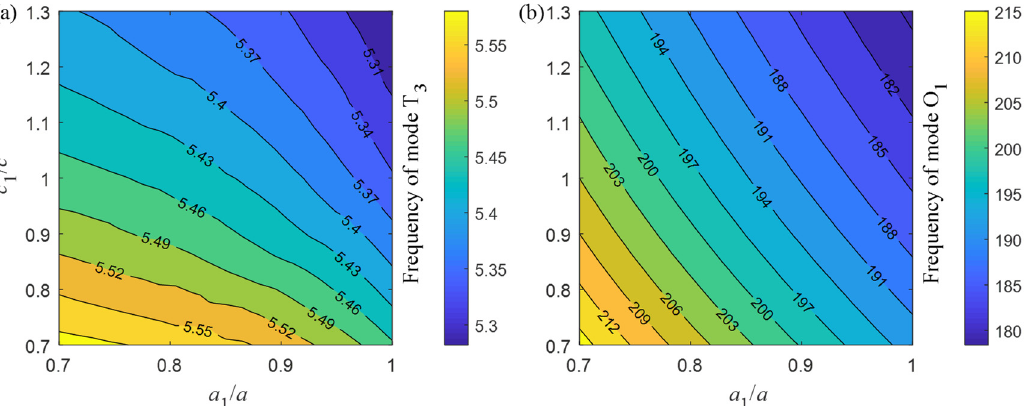
Figure 4. Frequency contours varying with geometrical parameters a 1 and c 1 for ( a ) mode T 3 , ( b ) mode O 1 .